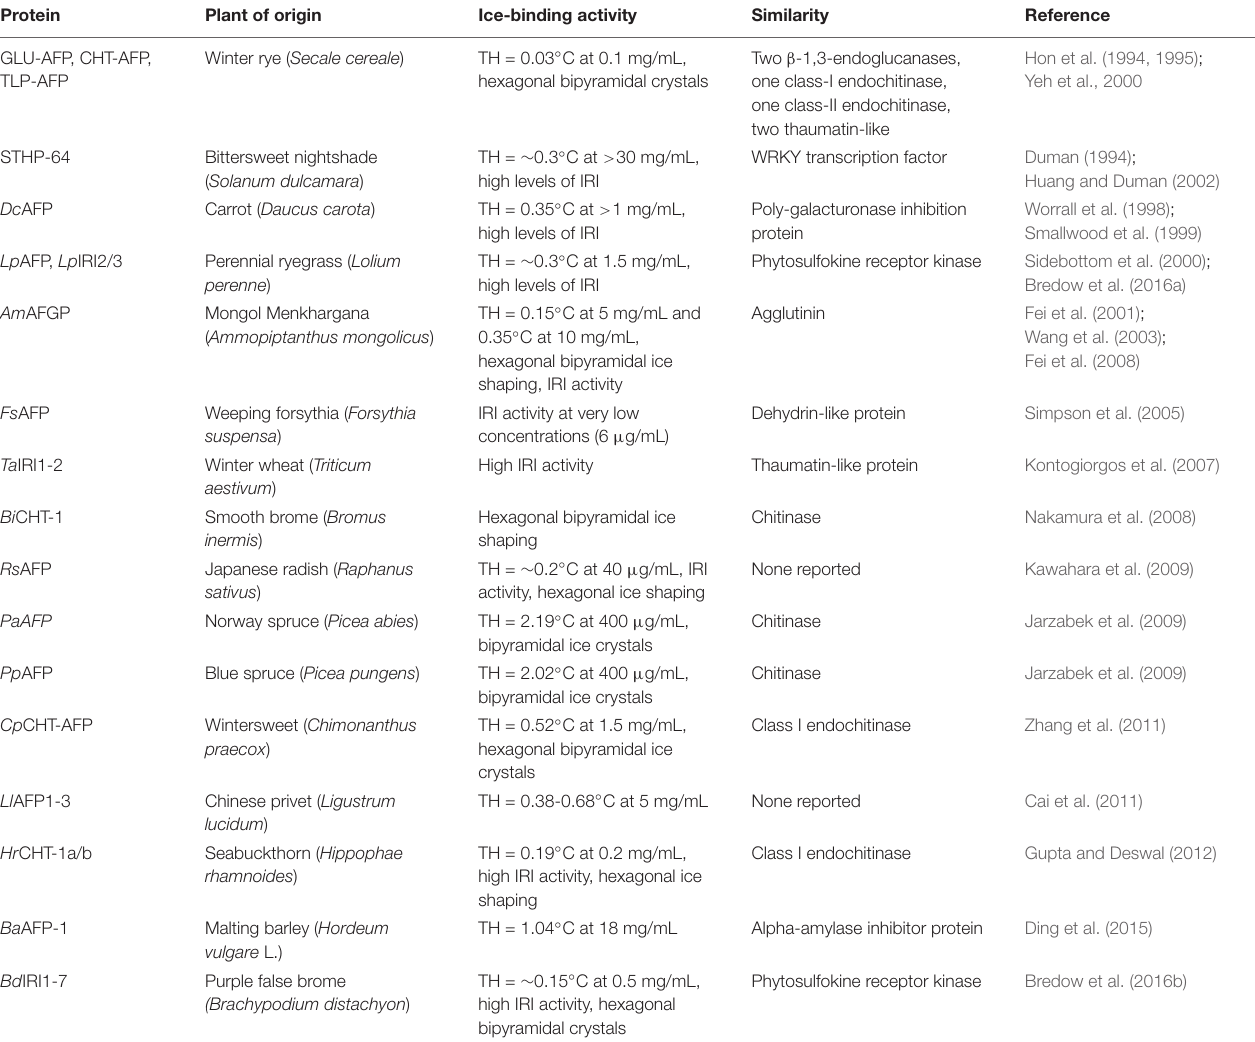
TABLE 1 | Activity of identified ice-binding proteins in plants and their similarity with other proteins. Protein Plant of origin Ice-binding activity Similarity